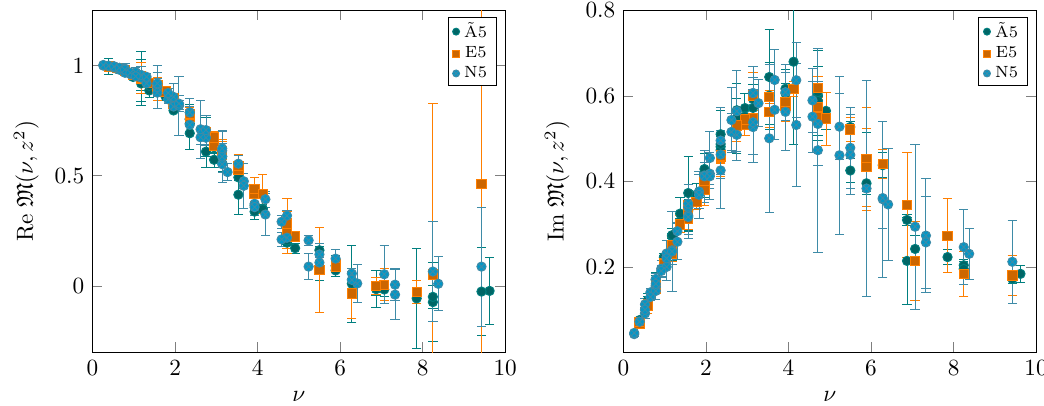
Figure 6 . The real (l.h.s.) and the imaginary (r.h.s.) part of the reduced ITDs of the three lattice ensembles used in this study. We see that for the range of Ioffe times that is covered by our data the three ensembles have a pretty good overlap. The statistical and systematic errors are added in